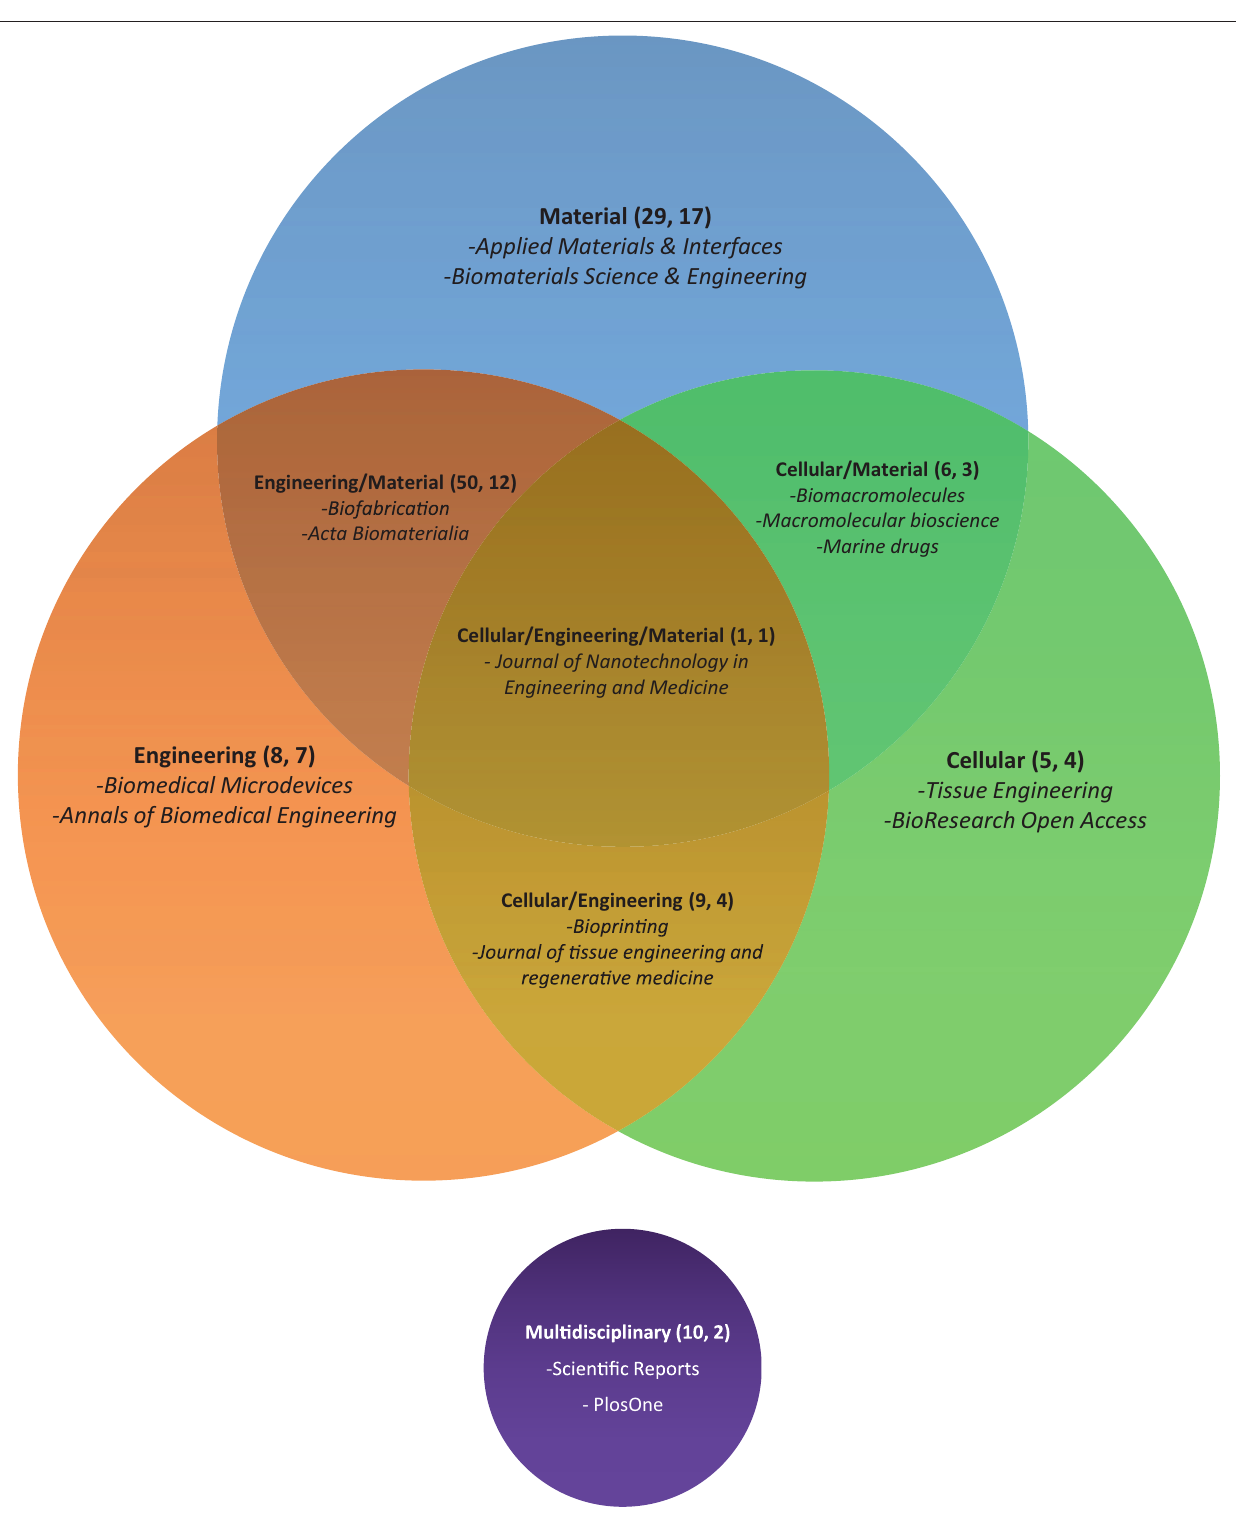
FIGURE 4 | Venn diagram of journals’ categories selected in this review according to JCR/SJR categories. Diagram information is organized as follows: Topic of the journal (number of papers, number of journals) and some of the most represented journals are listed. We noted that intersection areas are exclusive, and sizes are not